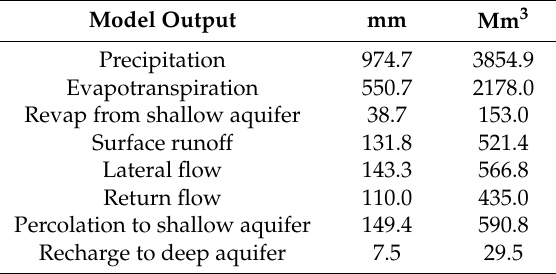
Table 2. Results of the Soil and Water Assessment Tool (SWAT) watershed model for Pirai River— annual means for the period 1992–2013 (water balance) in mm (millimeters) and Mm 3 (millions of cubic meters) for the actual situation (Scenario 1).